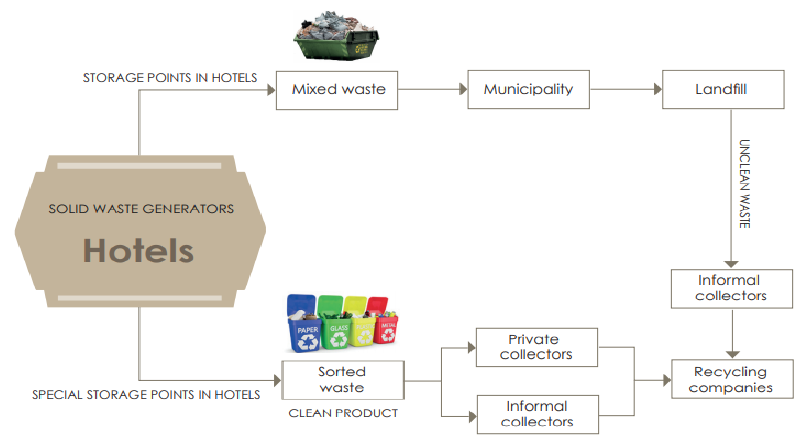
Figure 8. Case of SW sorting at the source in hotels in Tunisia.